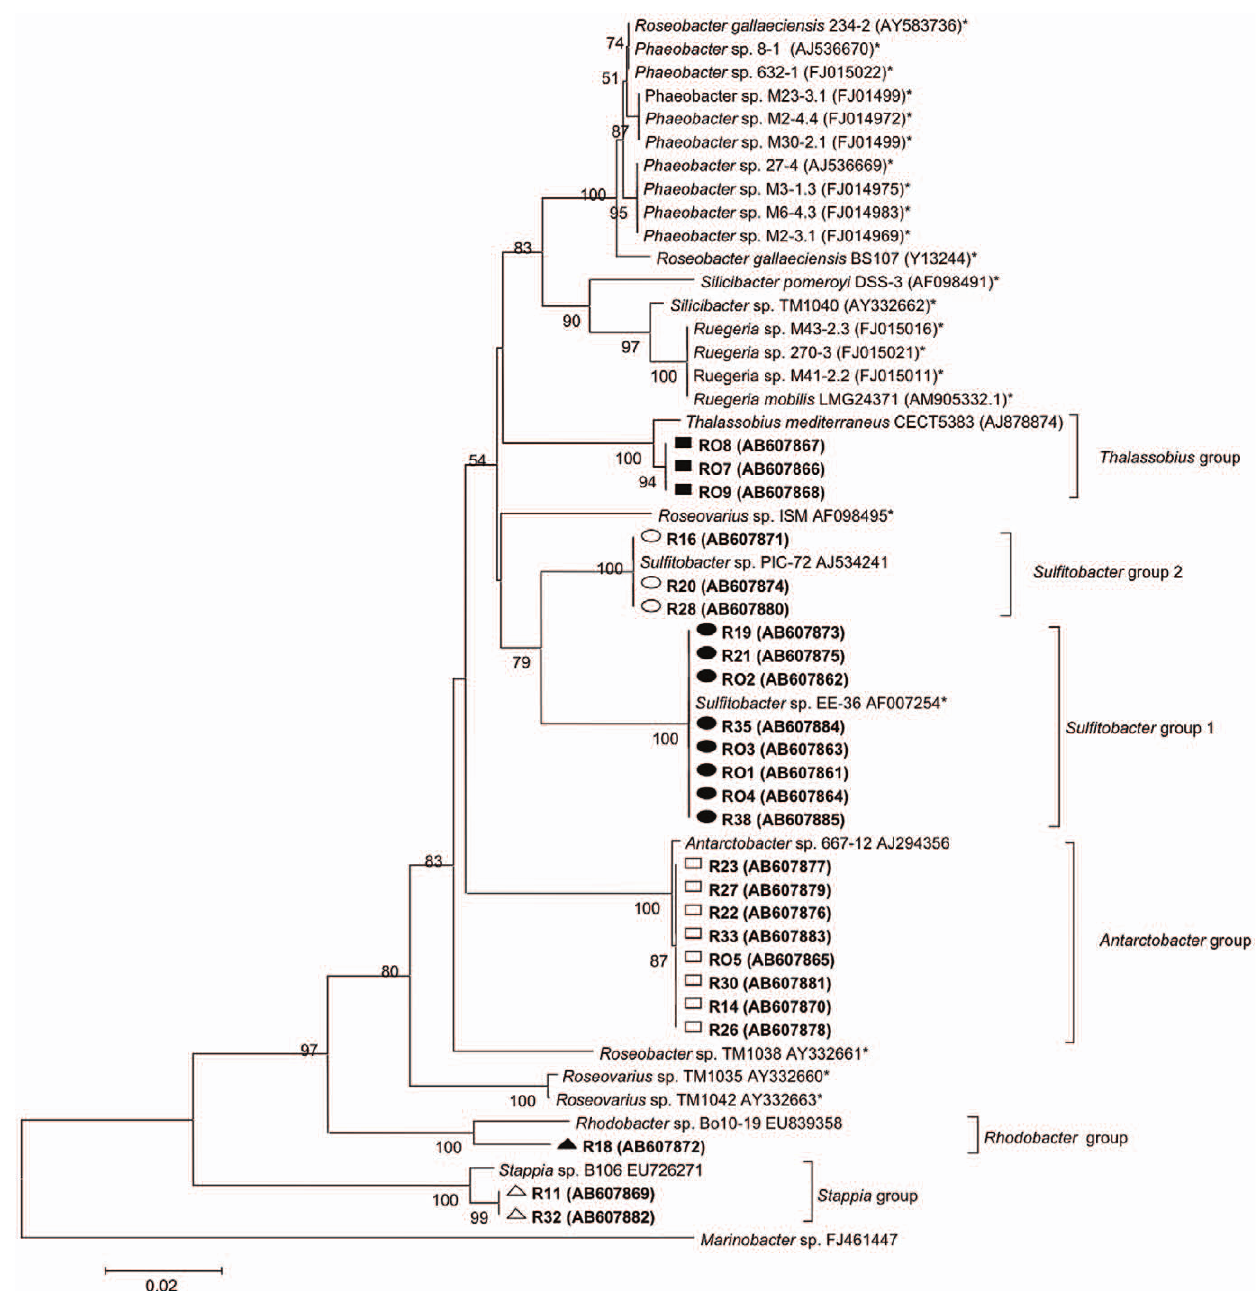
Figure 1. Phylogenetic tree of Roseobacter clade members isolated from Nannochloropsisoculata compared with potential probiotic species (*). Closed squares: Thalassobius group, open circles: Sulfitobacter group 2, closed circles: Sulfitobacter group 1, open squares: Antarctobacter group, closed triangles: Rhodobacter group, and open triangles: Stappia group. Numbers by the branches are bootstrap values from 1000 replicates ( . 50%). The scale bar indicates the number of base pair substitutions per nucleotide position. Marinobacter sp. was used as the outgroup. Roseobacter isolated in this study are in bold type. doi:10.1371/journal.pone.0026756.g001 ml, respectively, even in the presence of V. anguillarum . Other roseobacters showed the same growth patterns as Sulfitobacter sp. RO3 (triangles and circles in Fig. 2h) in ESM and NCF media when cocultured with V. anguillarum (data not shown).